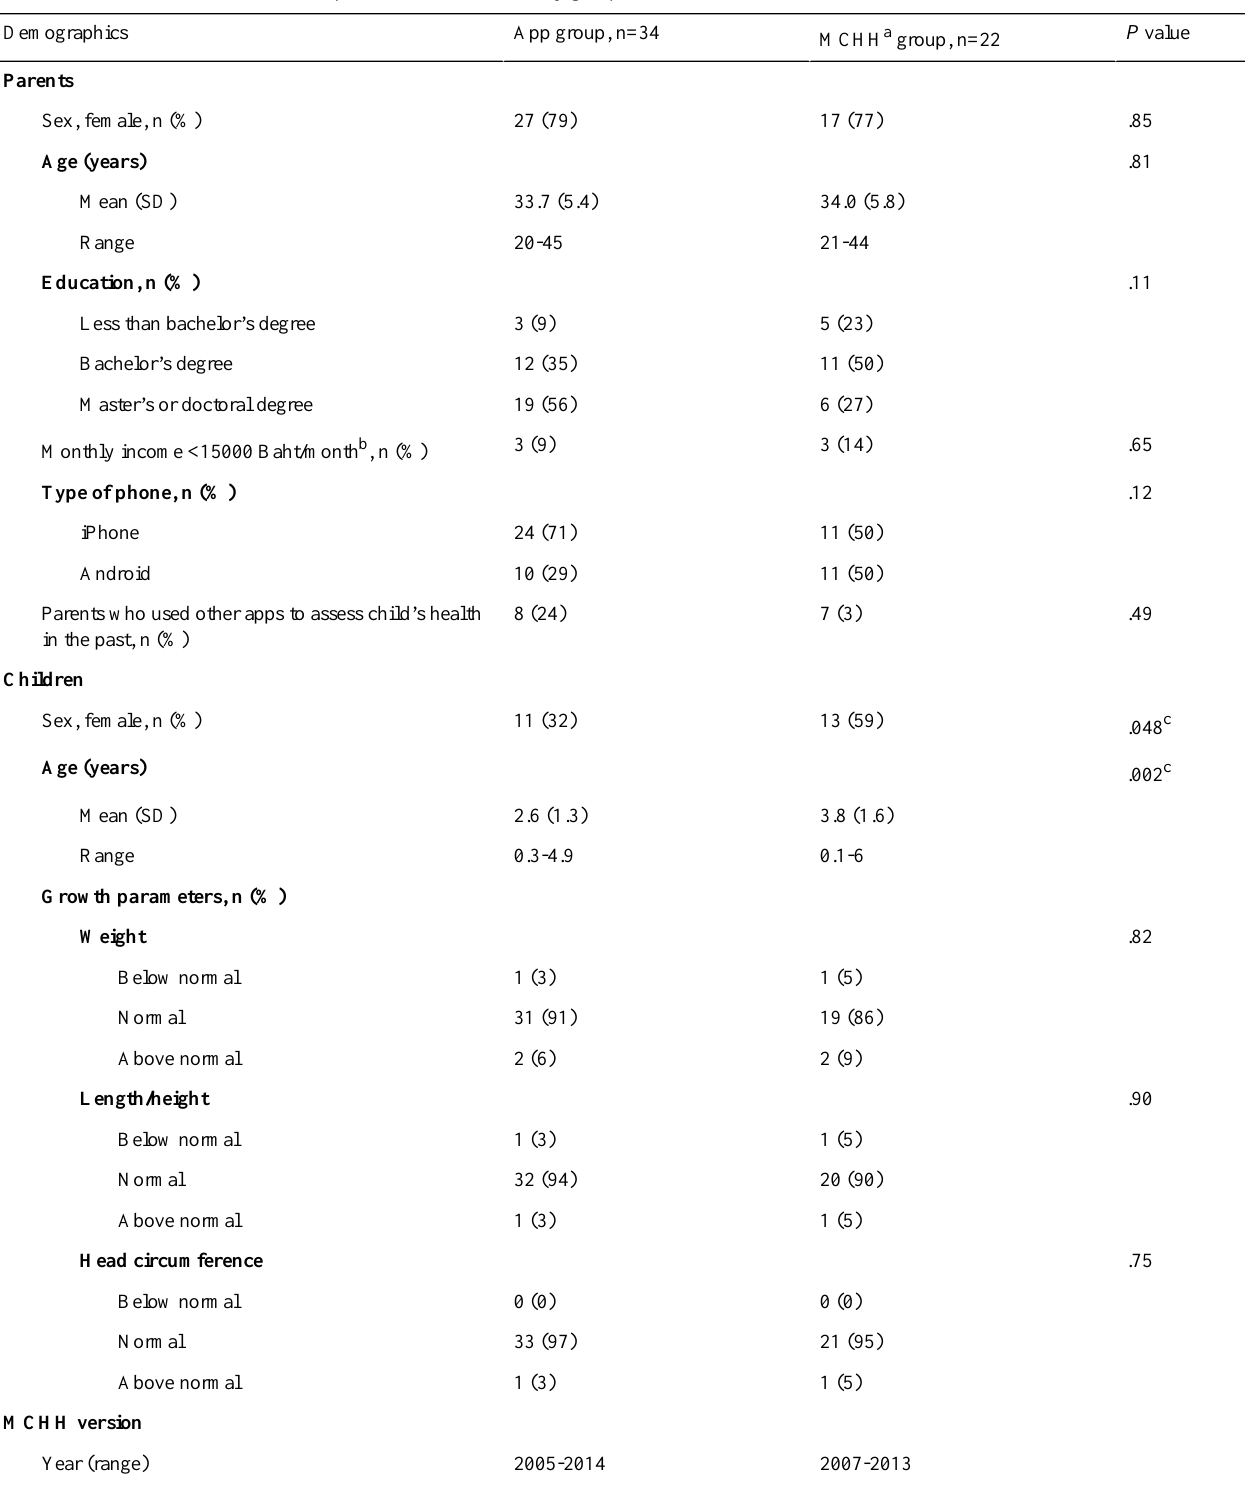
Table 2. Baseline characteristics of the parents and the children by